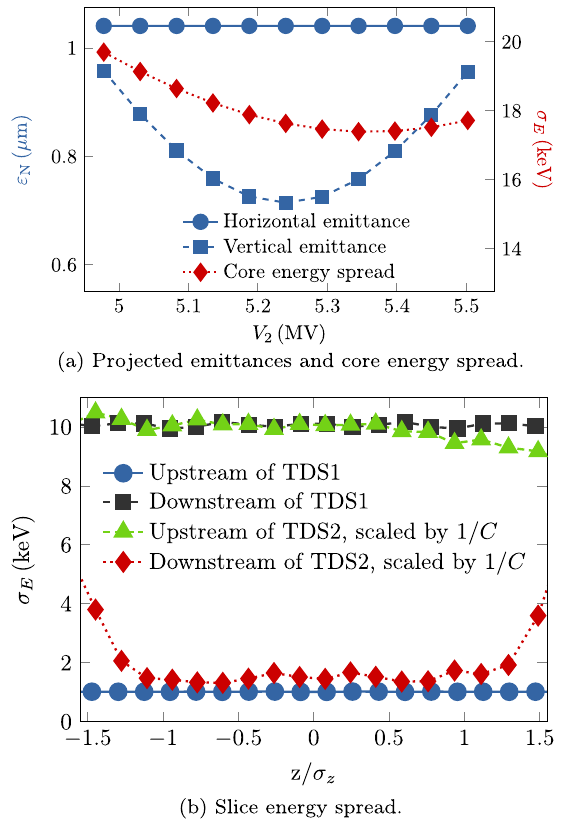
FIG. 5. Simulation on the impact of the reversible beam heater system on projected emittances, core energy spread, and slice energy spread: (a) Projected emittances (normalized) and core energy spread, and (b) slice energy spread for V 2 at minimum emittance [see Fig. 5(a)]. CSR effects are included by means of the 1-dimensional model in ELEGANT [35].